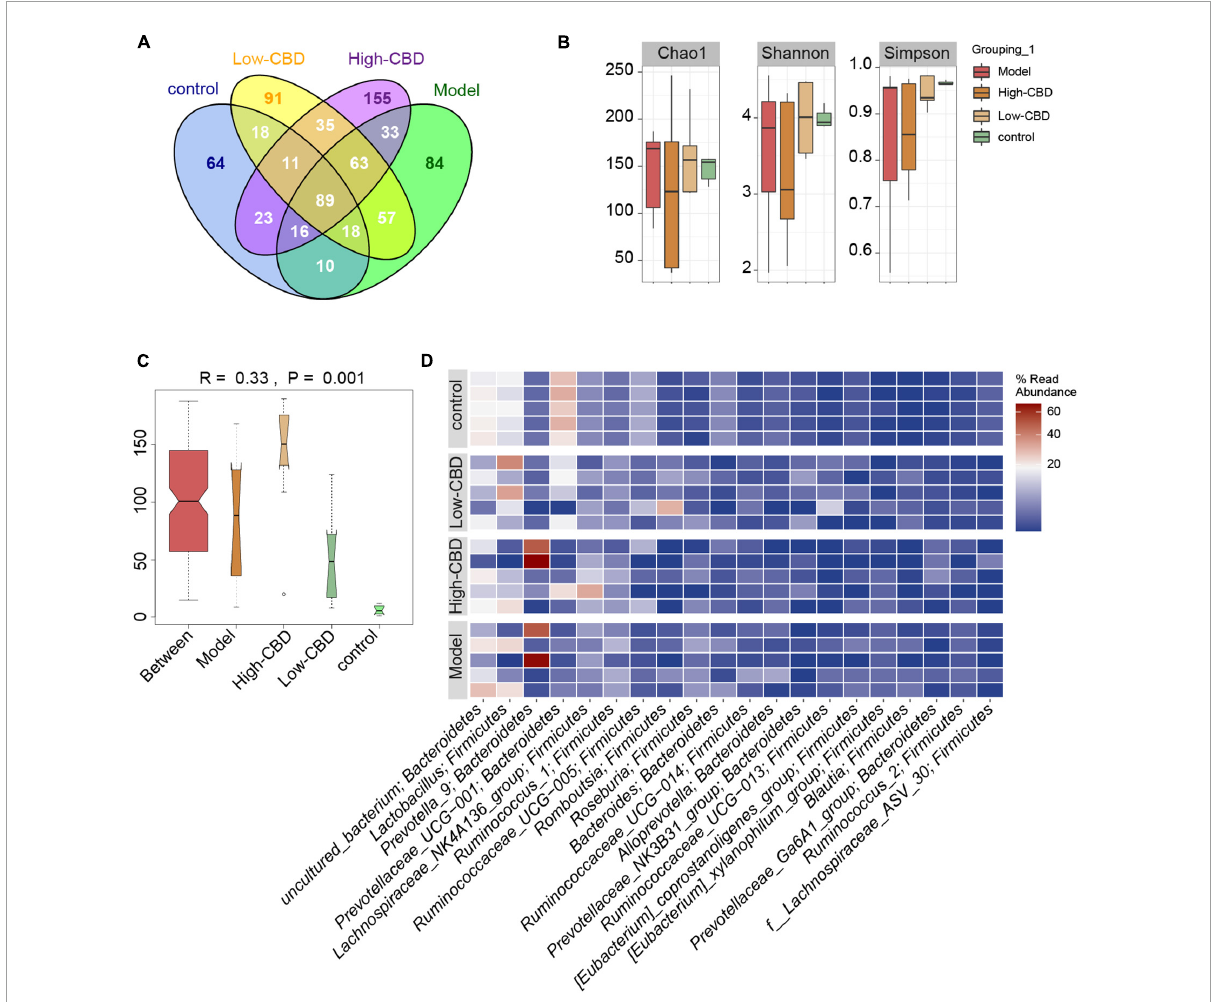
FIGURE5 Effects of cannabidiol (CBD) on the gut microbiota structure in epileptic rats. (A) Venn diagram. (B) α -diversity analysis. (C) ANOSIM analysis. (D) The Heat Map visualization of the abundance and classification information of the top 20 ASVs. A color change from blue to red represents higher